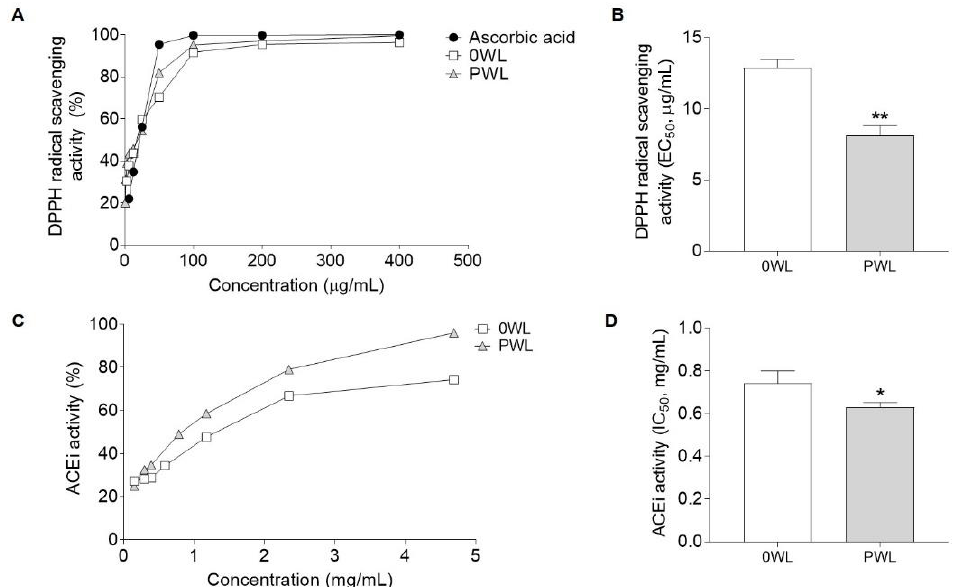
Figure 3. Dose–response curves of DPPH radical scavenging activity (%, A ) and angiotensin- converting enzyme inhibitory (ACEi) activity (%, C ) for control wine lees (0WL) and phenolic- enriched wine lees (PWL). Figure 3 ( B ) shows DPPH radical scavenging activity as EC 50 and ( D ) show ACEi activity as IC 50 . Values are the average of three replicates ± SD. Statistical differences by Student’s T-test between 0WL and PWL are indicated (*) when p < 0.05 and (**) when p < 0.01.